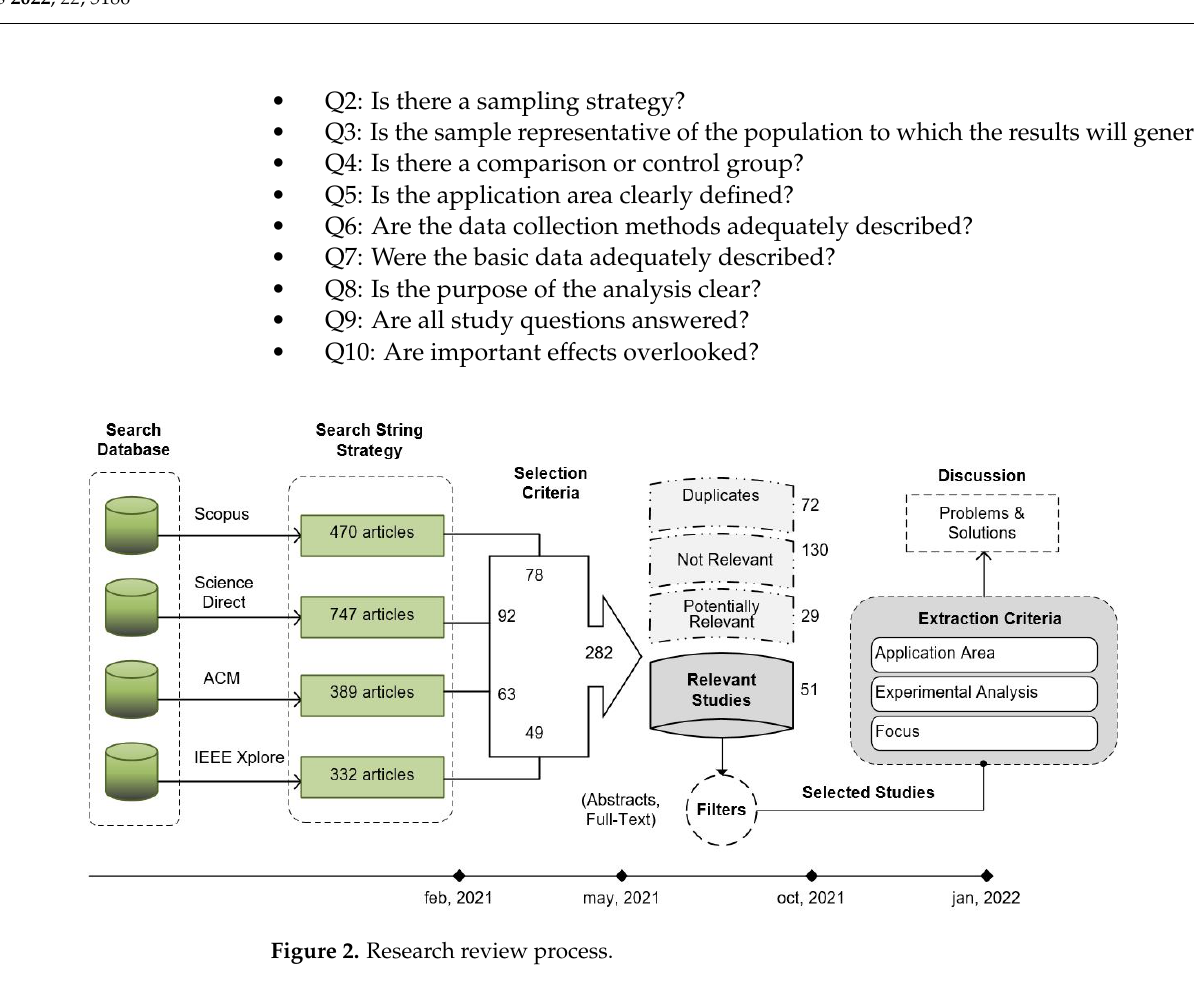
Table 3. A summary checklist for quality